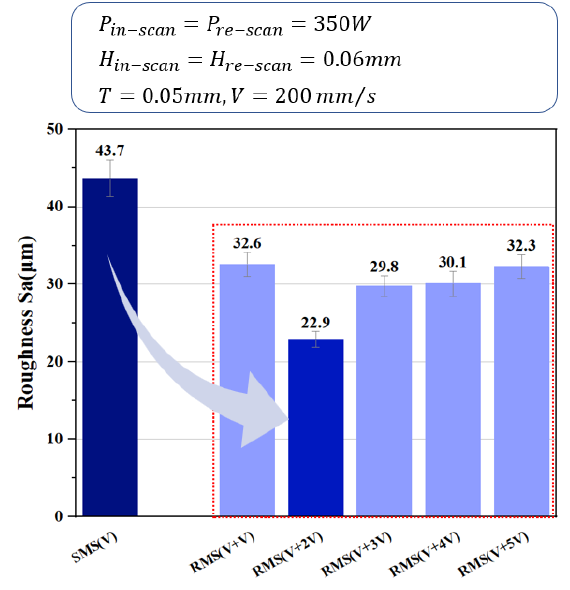
Figure 8. Influence of re ‐ scan speed on surface roughness of the sample.